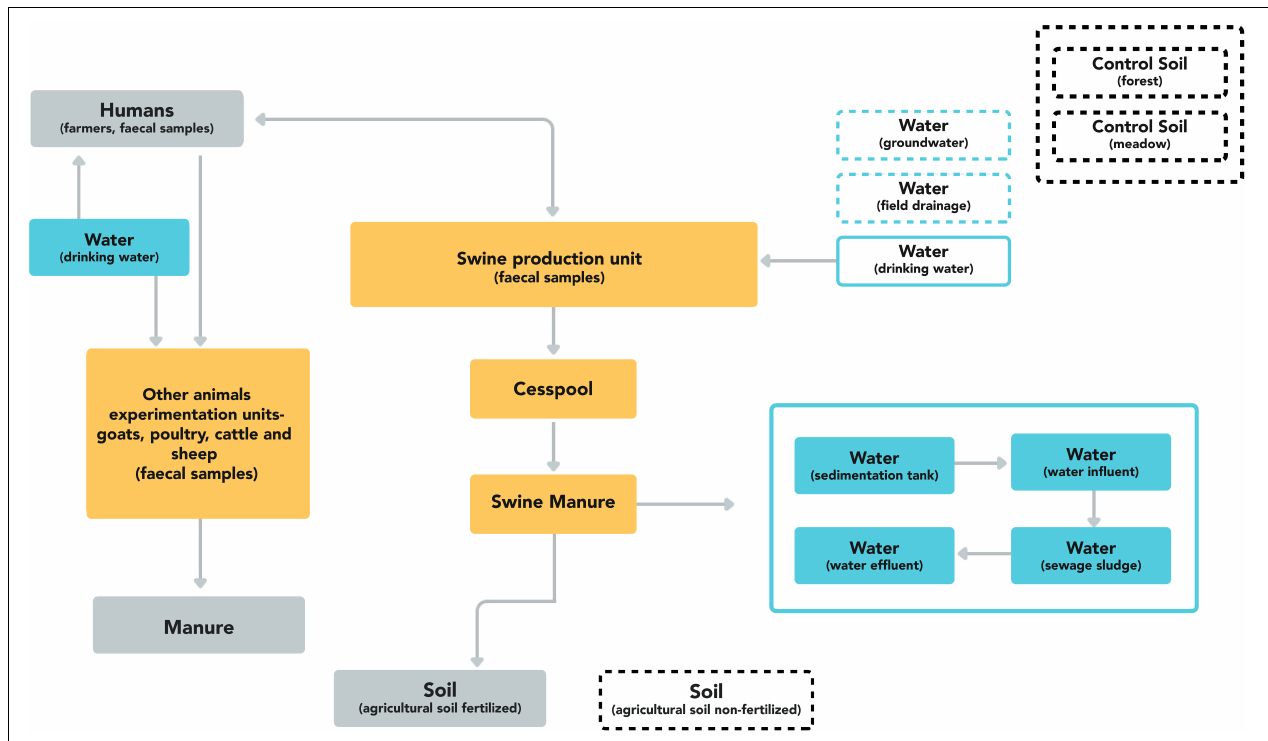
FIGURE 1 | Schematic representation of the environmental, human, and animal compartments and the respective connection between them. The dashed line boxes indicate sampled compartments with no connection to the animal production